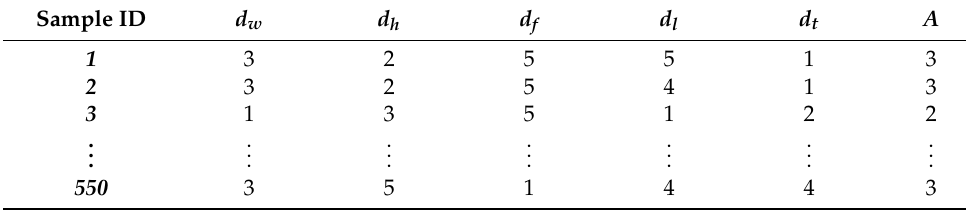
Table 8. Discrete training